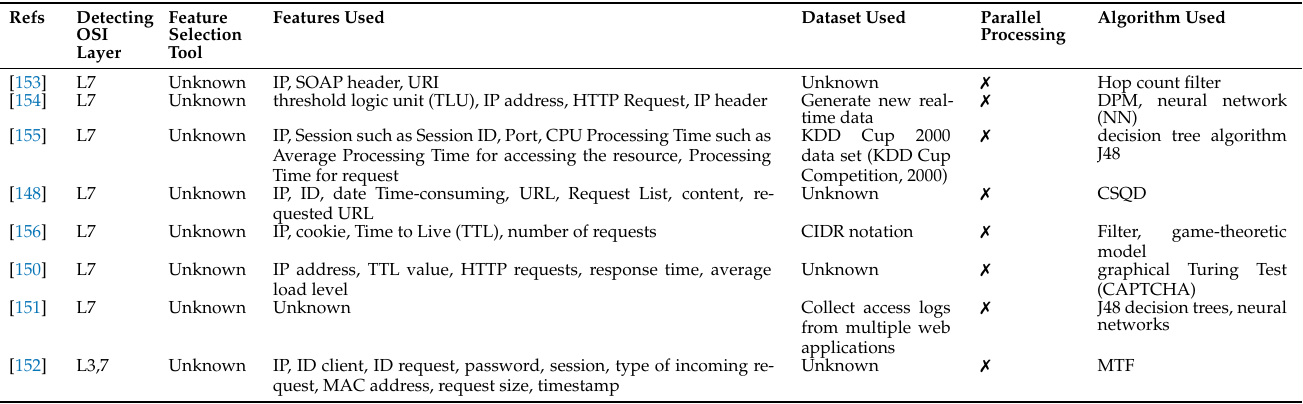
Table 16. DDoS attack detection approaches based on filtering tree.